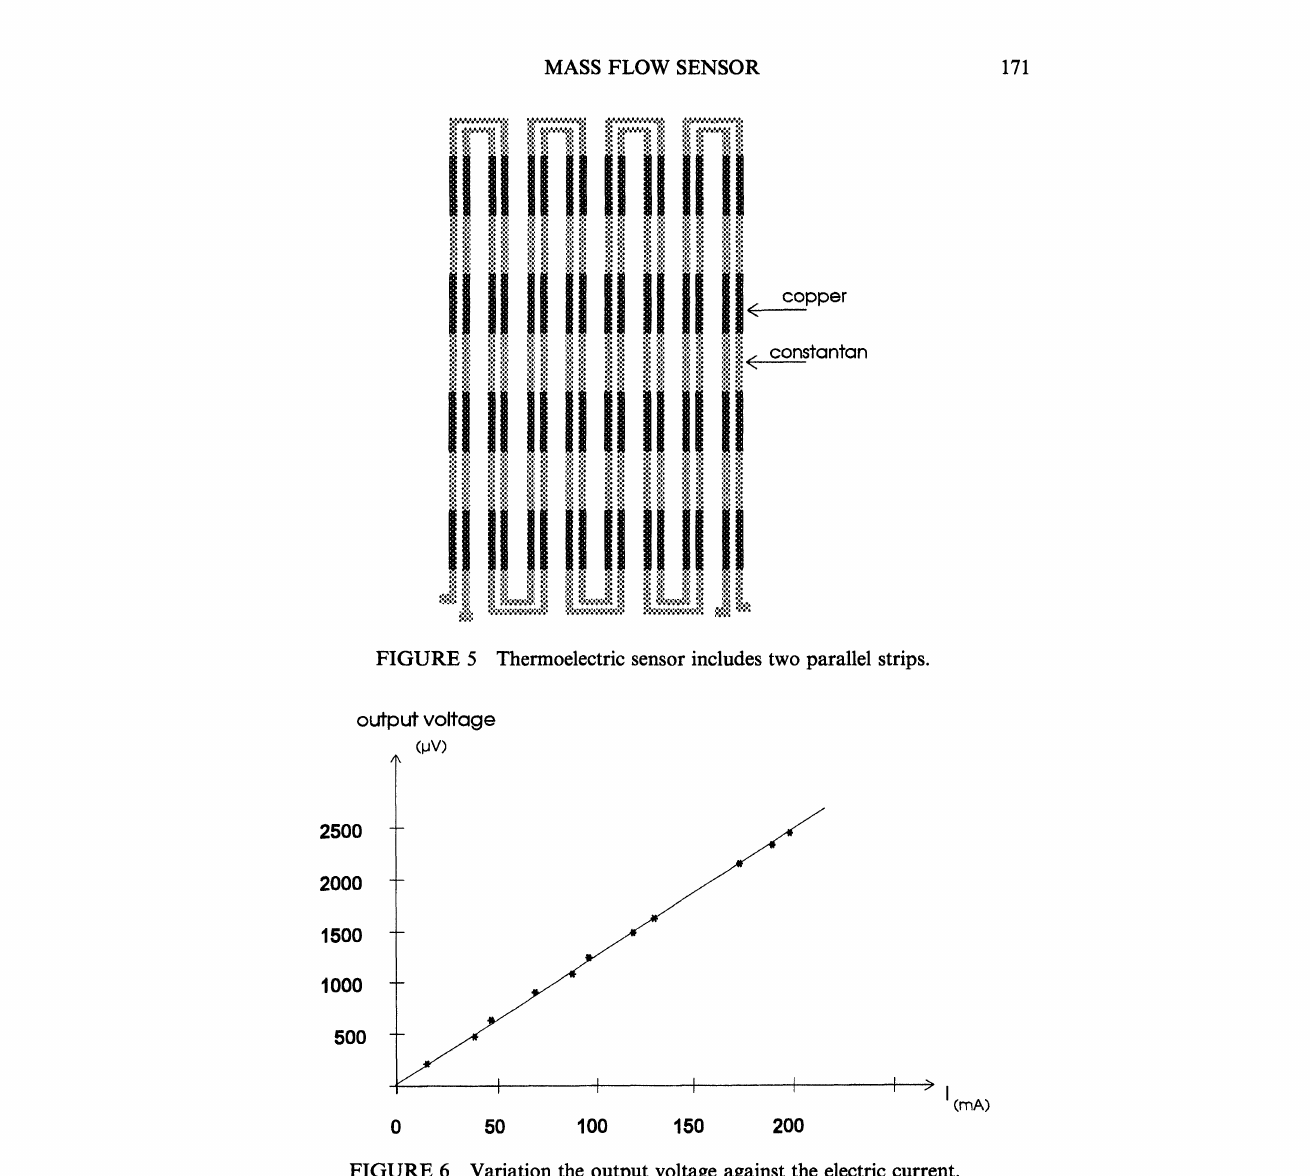
FIGURE 6 Variation the output voltage against the electric